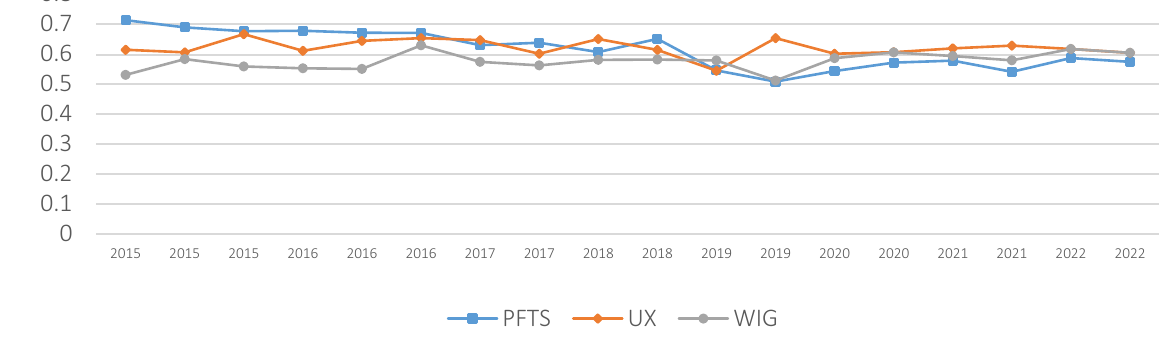
Figure 2. Dynamic R/S analysis results